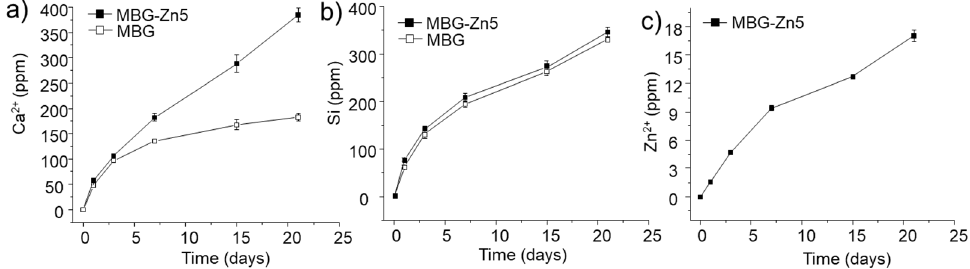
Figure 8. Concentration of Ca (a), Si (b), and Zn (c) as a function of soaking time in α -MEM obtained by ICP spectroscopy for MBG and MBG-Zn5.